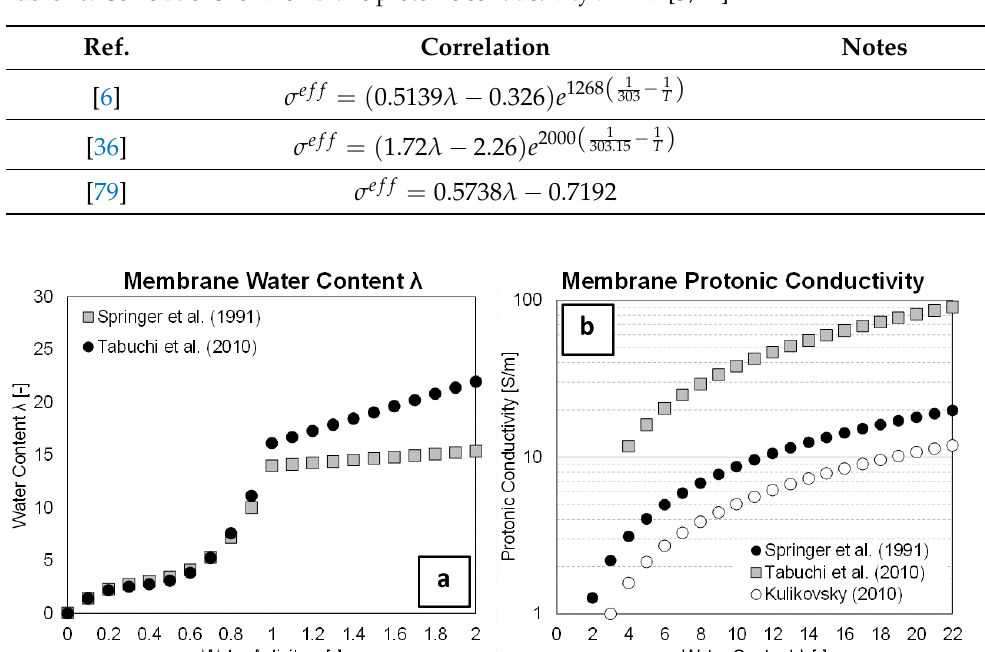
Figure 4. Left ( a ): Correlations for the membrane water content λ as a function of the water activity a . Right ( b ): Membrane protonic conductivity σ ef f from Table 11.